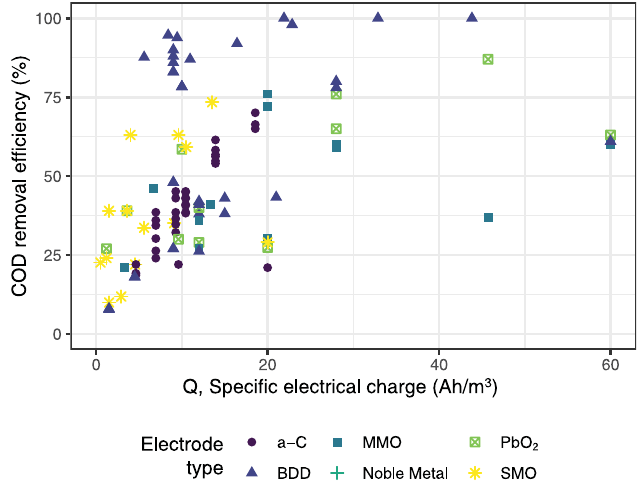
Fig. 2. COD removal ef fi ciencies versus the speci fi c electrical